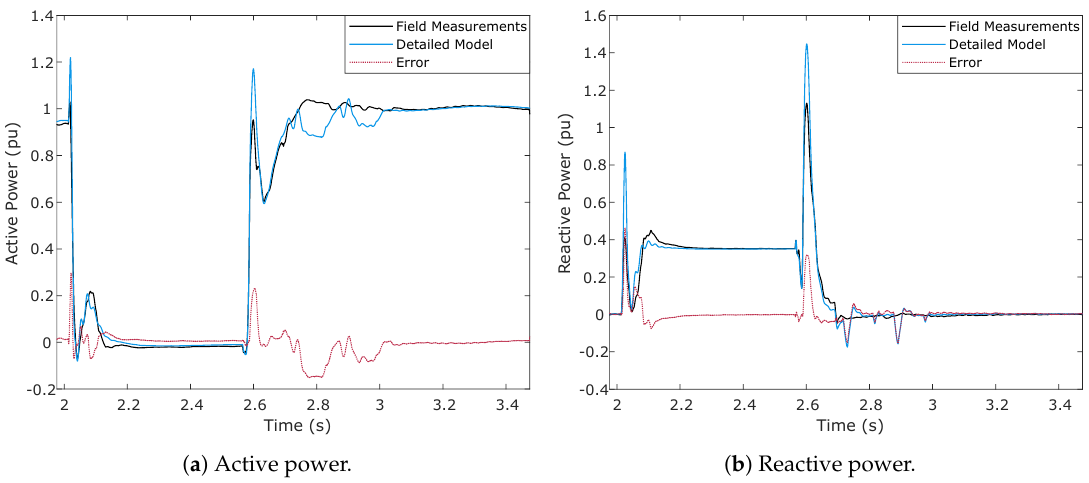
Figure 2. Active and reactive power comparison between the field measurements and the simulation responses of a Siemens Gamesa G52 WT under a voltage dip with WT operating at full load conditions.